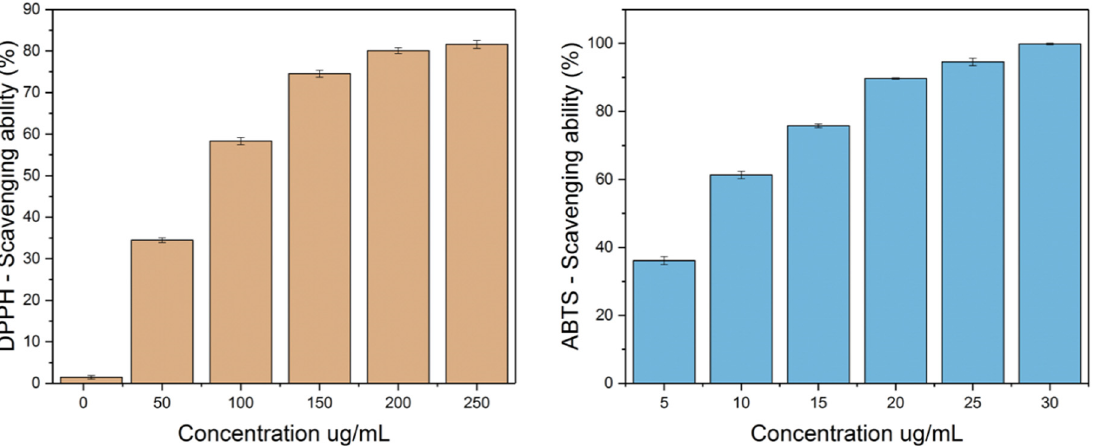
Figure 6. Antioxidant activity of lignin from residual sawdust of eucalyptus according to DPPH (left) and ABTS (right) assays.